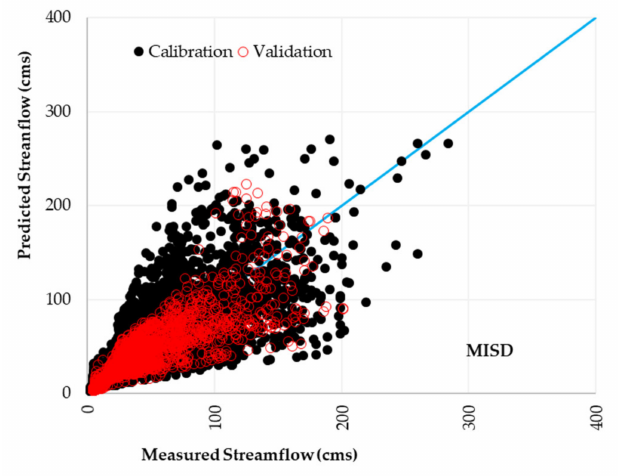
Figure 5. Scatter plots of observed vs. simulated streamflow by the MISD